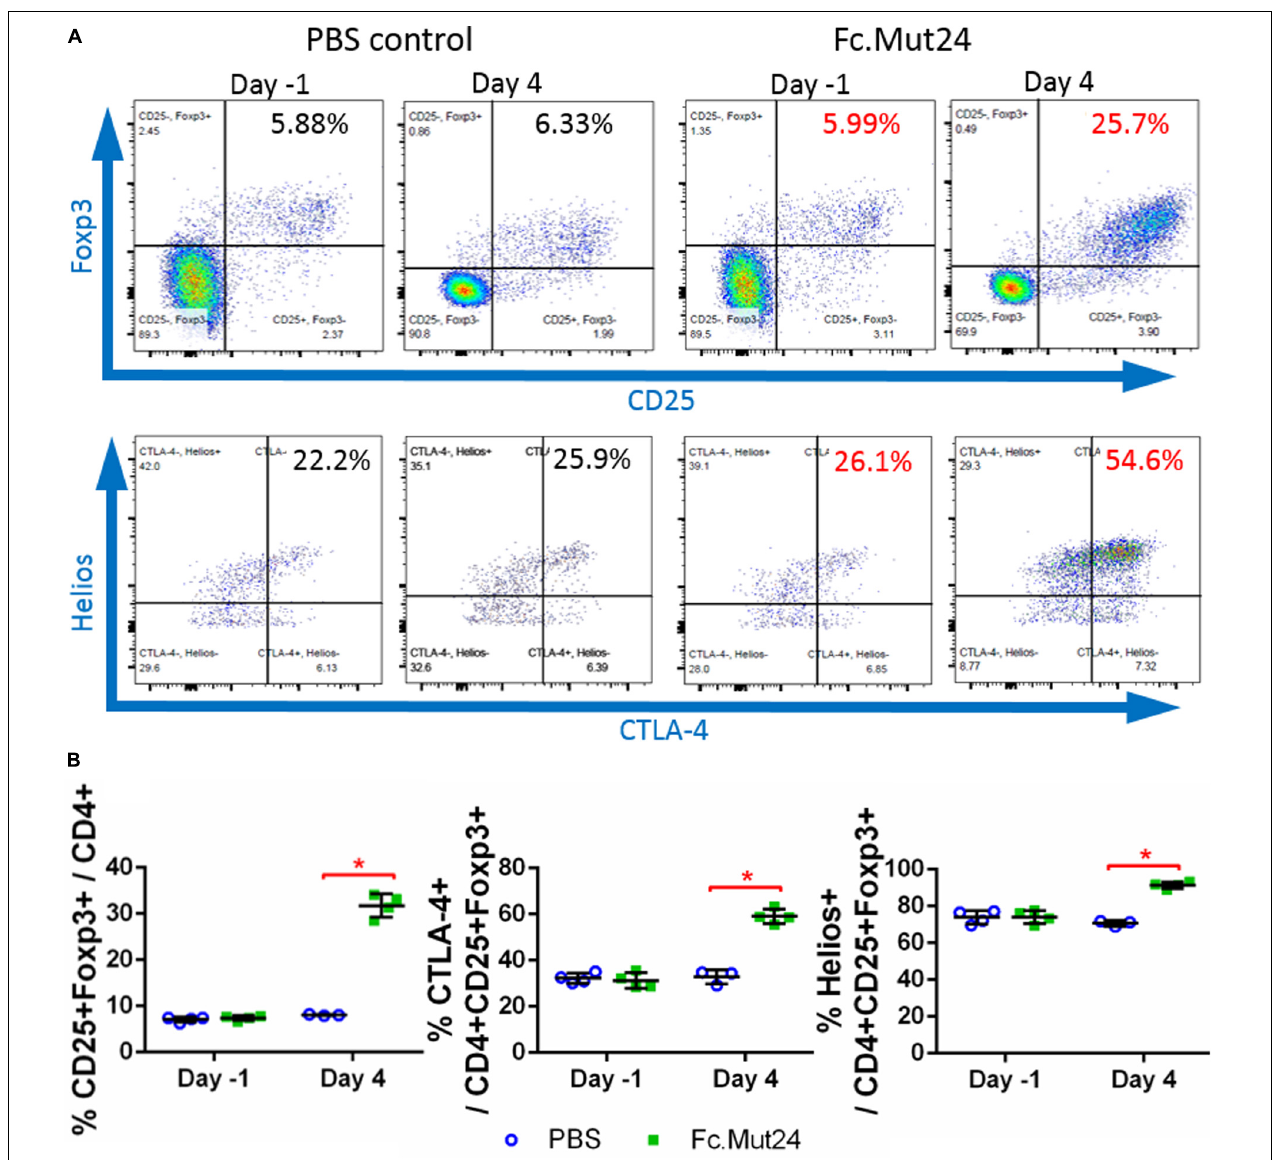
FIGURE 1 | Analysis of changes in CD4 + CD25 + Foxp3 + Tregs by IL-2 Fc.Mut24 treatment. Fc.Mut24 was administered to HemA mice ( n = 4) and lymphocyte populations were compared to mice receiving phosphate-buffered saline (PBS) injections ( n = 3). (A) Representative flow cytometry plots of CD4 + peripheral blood lymphocytes to determine the percentage of the Treg population, defined by double-positive CD25 and Foxp3 expression (top row). CD25 + Foxp3 + Tregs were gated to determine the activation percentage, defined by CTLA-4 expression (bottom row). (B) Comparison of percentages of Tregs (left), activated Tregs (middle), and Helios + Tregs (right) between PBS- and Fc.Mut24-treated mice on Day 1 and Day 4. The experiments were repeated three times with no significant variation. The data are presented as means with standard deviation. The p -values were calculated at individual time points by non-parametric Mann–Whitney U test (* p <